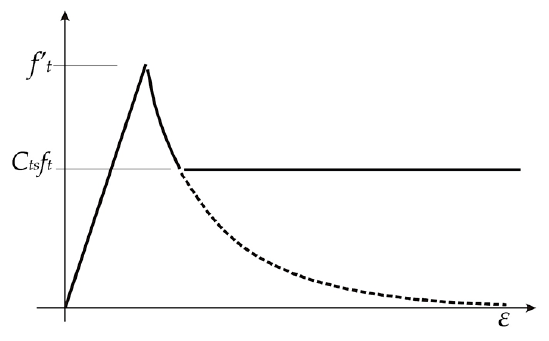
Figure 4. Tension Stiffening [18].